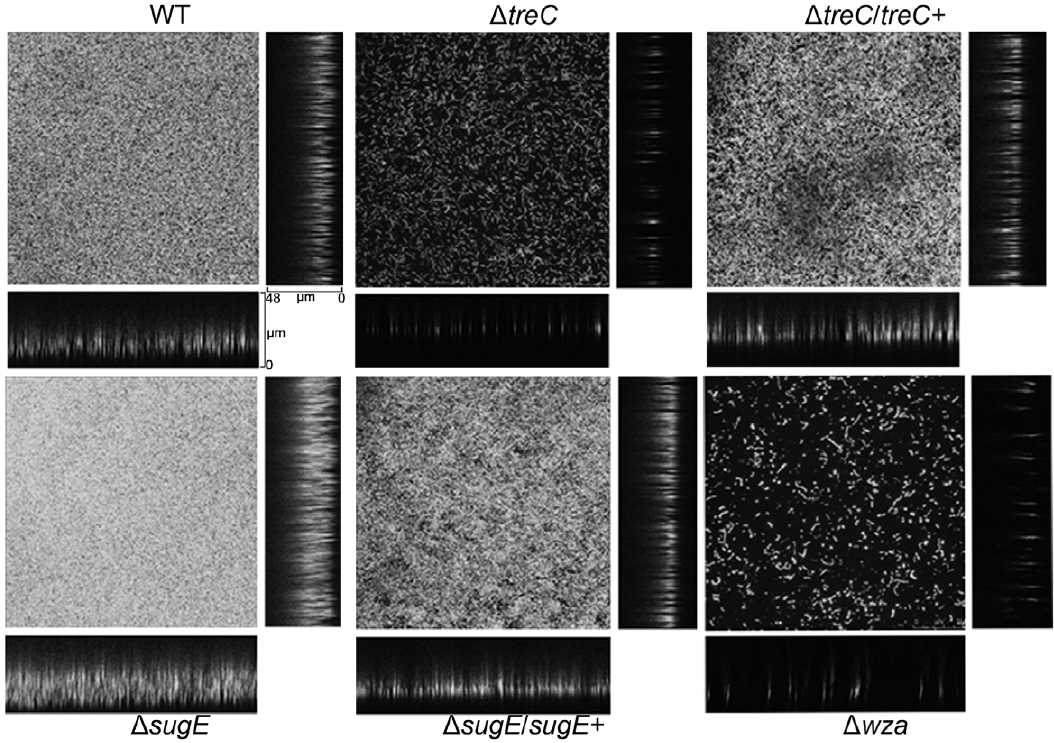
Figure 5. Biofilm formation by K.pneumoniae NTUH-K2044 and its isogenic mutants. Cover slides were placed into 24-well plates, which had been paved with glass beads. GFP-expressing K. pneumoniae strains were cultured overnight, inoculated into fresh LB for 18 h. The cover slides were washed with 1 6 PBS twice while shaking. The fluorescent signals were examined with a confocal microscope under 400 6 . The photographs depicted mimic images through the x–y plot (central), the y–z plot (right), and the x–z plot (below) of the biofilms. Data represent one of three independent experiments.